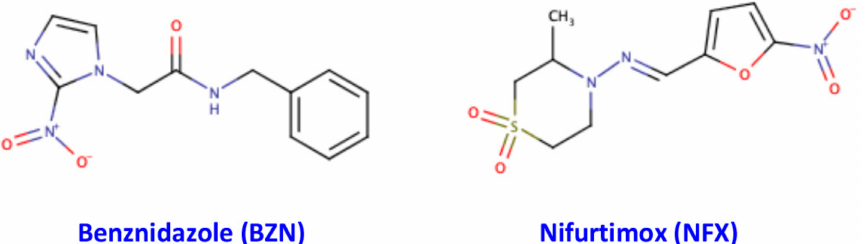
Figure 1. Chemical structures of Benznidazole (BZN) and Nifurtimox (NFX). Benznidazole, (IUPAC name: N-benzyl-2-(2-nitro-1H-imidazol-1-yl)acetamide) and Nifurtimox (IUPAC name: 3-methyl- 4-[(E)-[(5-nitrofuran-2-yl)methylidene]amino]-1lambda6-thiomorpholine-1,1-dione) are